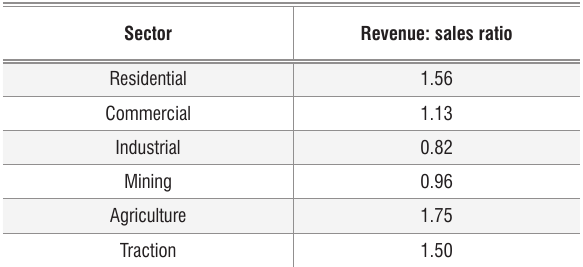
Revenue, per sector, from local electricity sales by Eskom in million rands. Revenue-to-sales ratio of electricity in South Africa, per sector